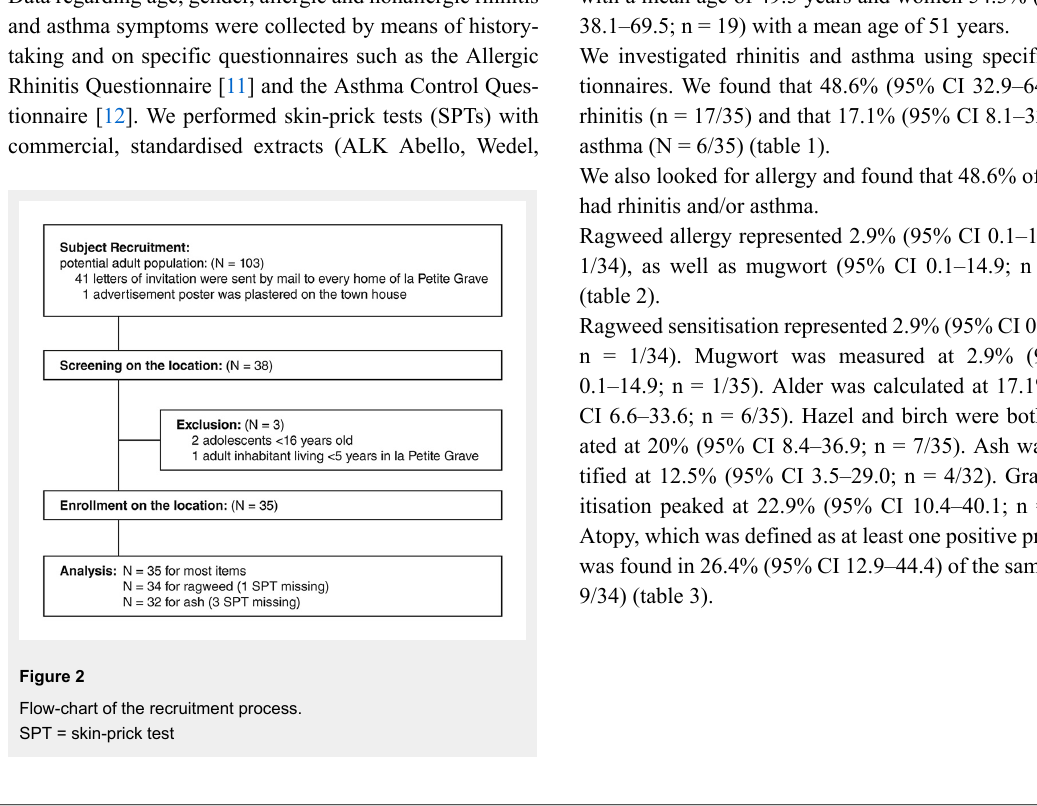
Table 1: The prevalence of allergy was calculated with the 95% confidence intervals of the proportion which were assessed by the exact method of Clopper-Pearson.